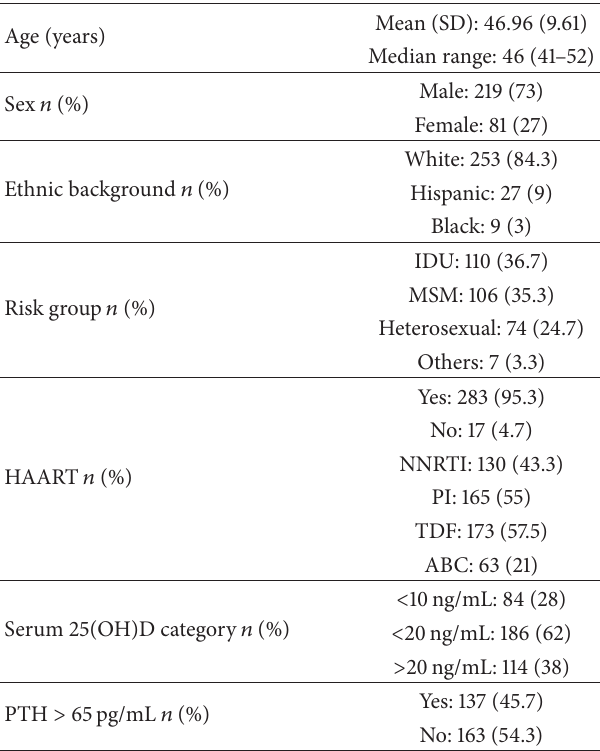
Table 1: Demographic and clinical characteristics of the study